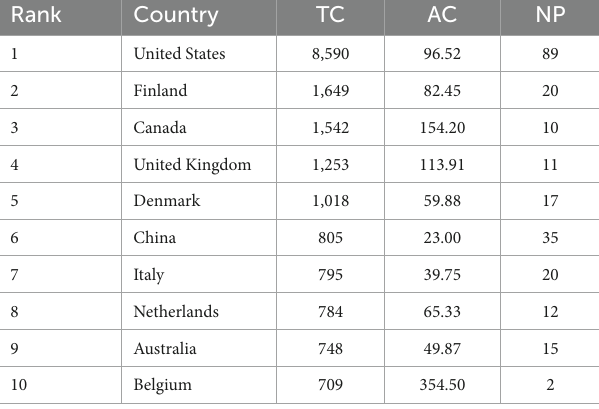
TABLE 2 Top 10 most productive countries/regions.